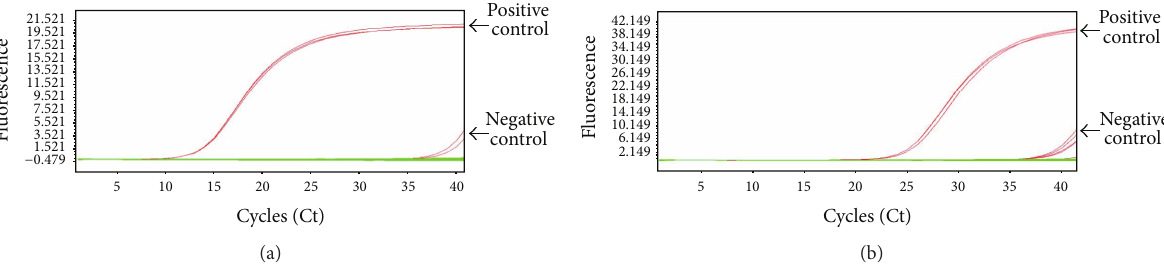
Figure 6: Analysis of the presence of the SYT-SSX fusion gene in whole blood, the mononuclear cell fraction, and serum microvesicles of synovial sarcoma patients by nested qPCR (a) and qPCR (b). Synovial sarcoma cells: positive control. Negative controls showed positivity at Ct-cycles ≥ 39. Patient samples showed Ct-cycles > 39 and were thus interpreted as